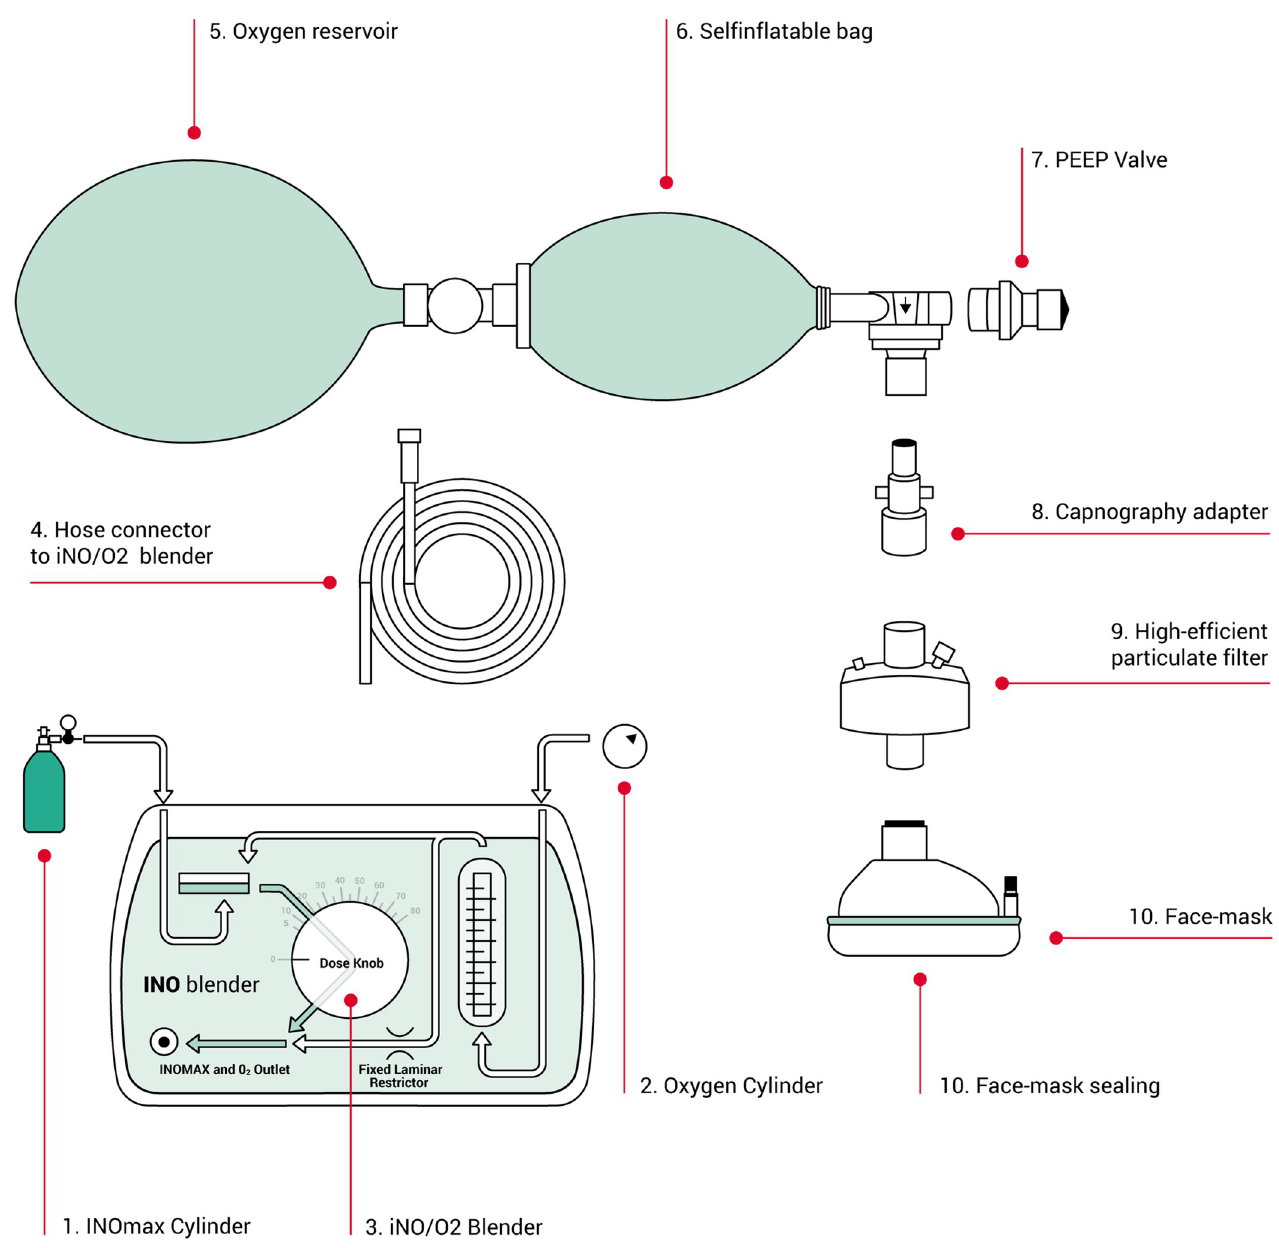
Fig 2. iNO equipment